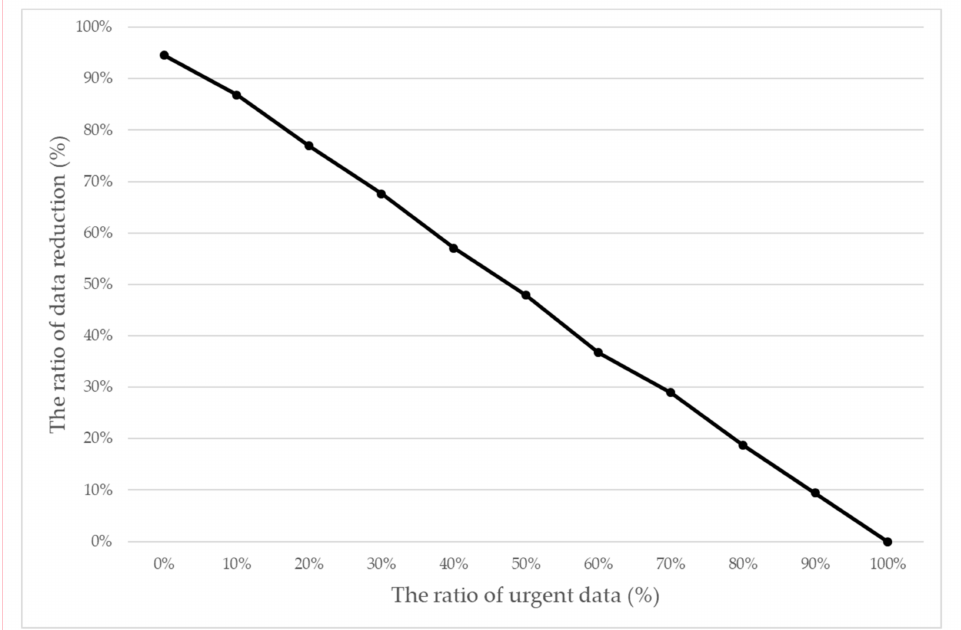
Figure 9. The ratio of transmission data reduction when the ratio of urgent data changes.